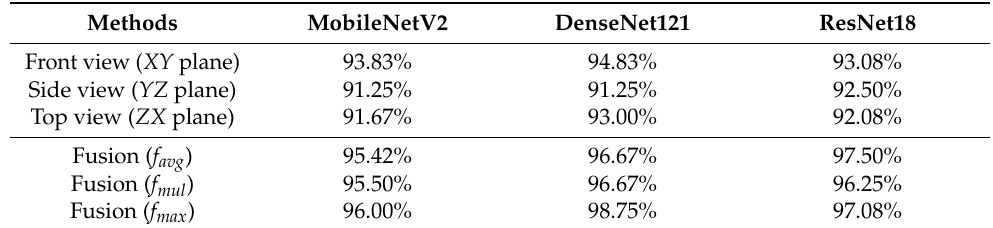
Table 3. Human activity recognition with different modality and models using MSR-Action3D dataset.